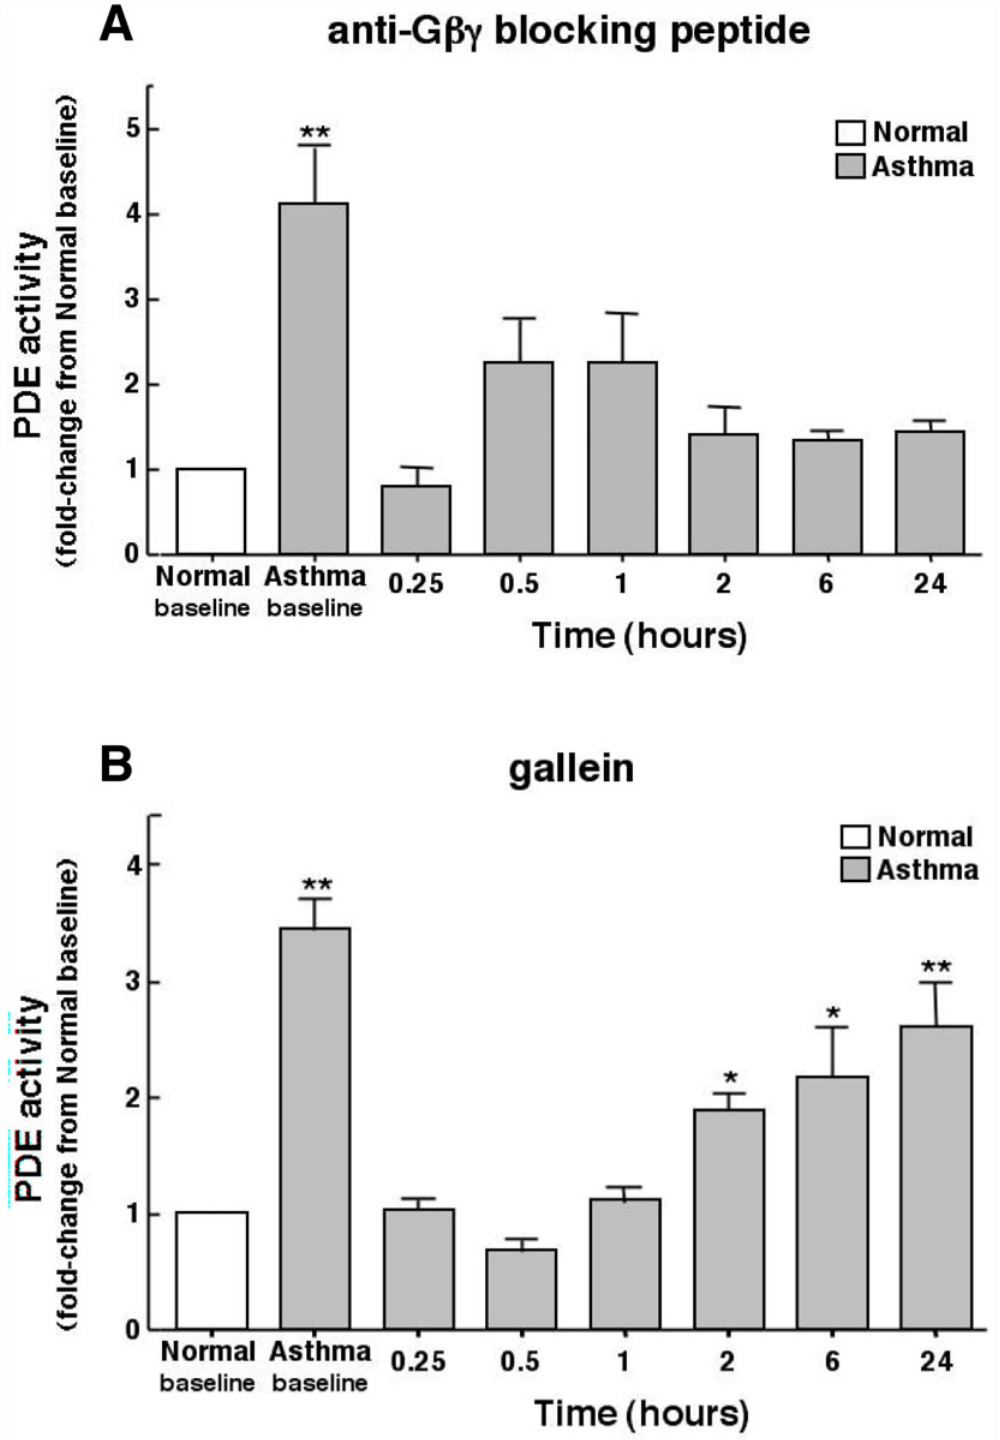
Fig 1. Inhibition of G βγ signaling suppresses intrinsically increased PDE activity in asthmatic HASM cells: Comparison of suppressive effects of anti-G βγ blocking peptide vs. gallein. Relative to normal cells, asthmatic HASM cells exhibit significantly increased constitutive (baseline) PDE activity. Inhibition of G βγ signaling with a maximal effective concentration (1 μ M) of either anti-G βγ blocking peptide ( A ) or gallein ( B ) acutely suppresses PDE activity in asthmatic HASM cells to normal levels at 0.25 hr. Contrasting sustained inhibition of PDE activity in cells treated with anti-G βγ blocking peptide, suppression of PDE activity in asthmatic HASM cells treated with gallein is transient, with progressive recovery in PDE activity after 1 hr that approaches near